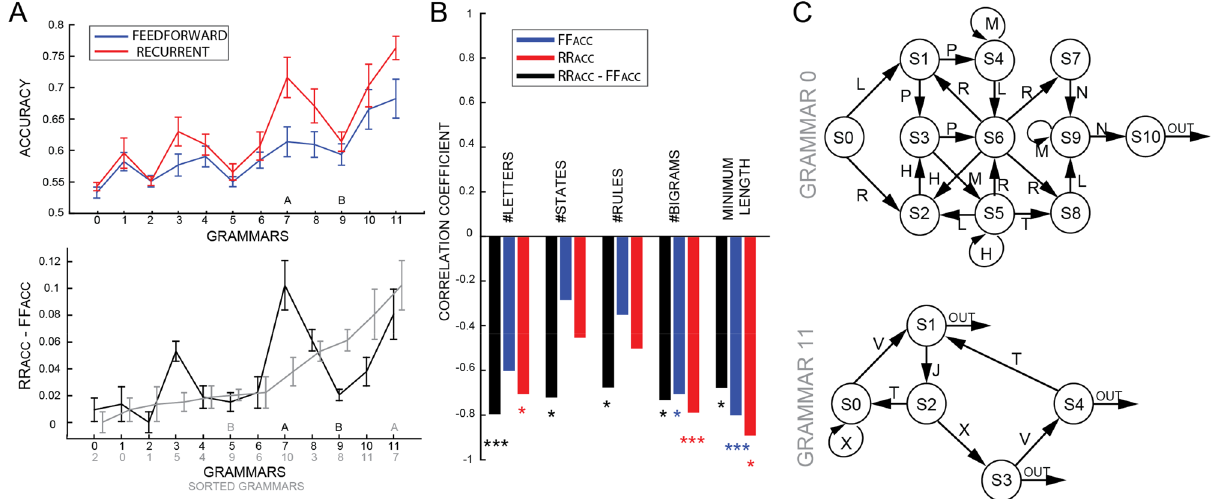
Figure 5. ( A ) The upper panel shows the performance of FF (in blue) and RR (in red) architectures for each grammar (from 1 to 10 of the x-axis), averaging over 20 initialization over a training set of 500 trials. Error bars represent standard errors of the mean. Grammars A and B are respectively 7 and 9. The difference in the performance between the two architectures is shown in the lower panel (the same sorted difference in light grey). ( B ) Pearson indexes obtained correlating the performance of FF and RR networks and their difference (respectively in blue, red and black) with the 5 complexity metrics across the 10 grammars. ( C ) The two novel grammars we designed at the 2 extremes of the complexity index to test our